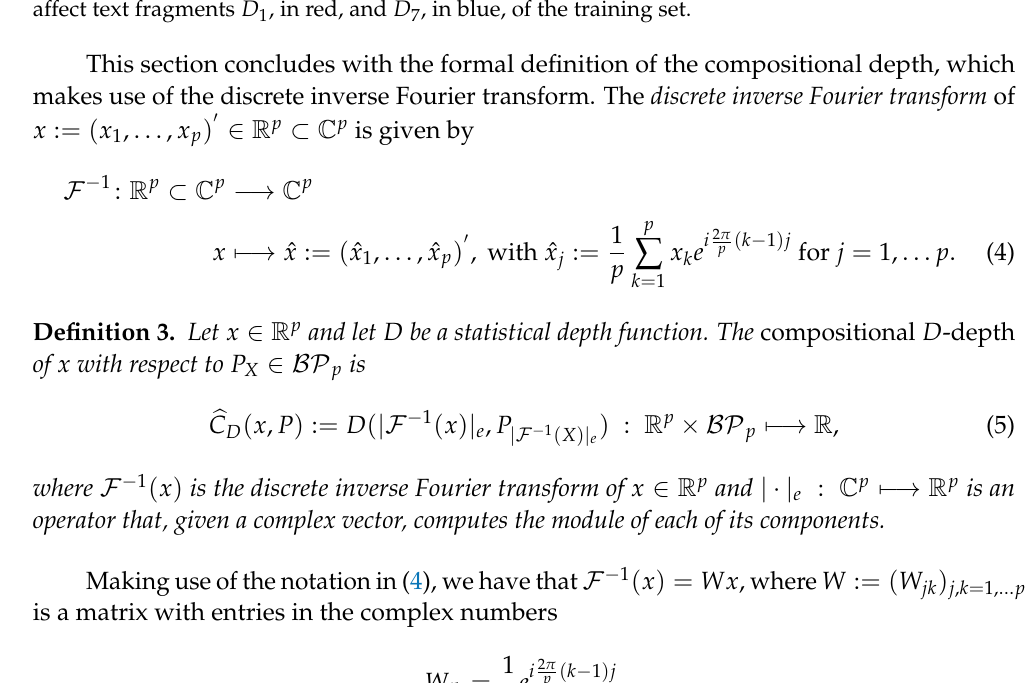
Figure 6. Schematic representation of the idea behind the compositional depth. The upper part shows the frequency decomposition of a wave in the time domain via the Fourier transform (FT). The inverse is also represented (IFT). The lower part illustrates how the inverse Fourier transformation affect text fragments D 1 , in red, and D 7 , in blue, of the training